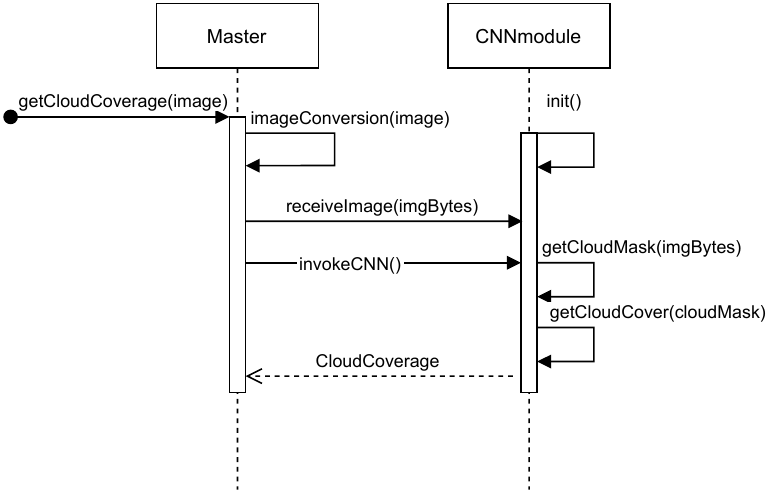
Figure 2. Information flow between the proposed module and a master device. Performance of NU-Net under Unseen